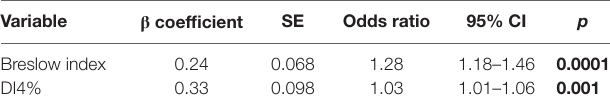
TaBle 8 | Logistic regression analysis showing the independent relationships between the Breslow index and DI4% values and the presence of high expression levels of hypoxia inducible factor-1 α in cutaneous melanoma tumors.